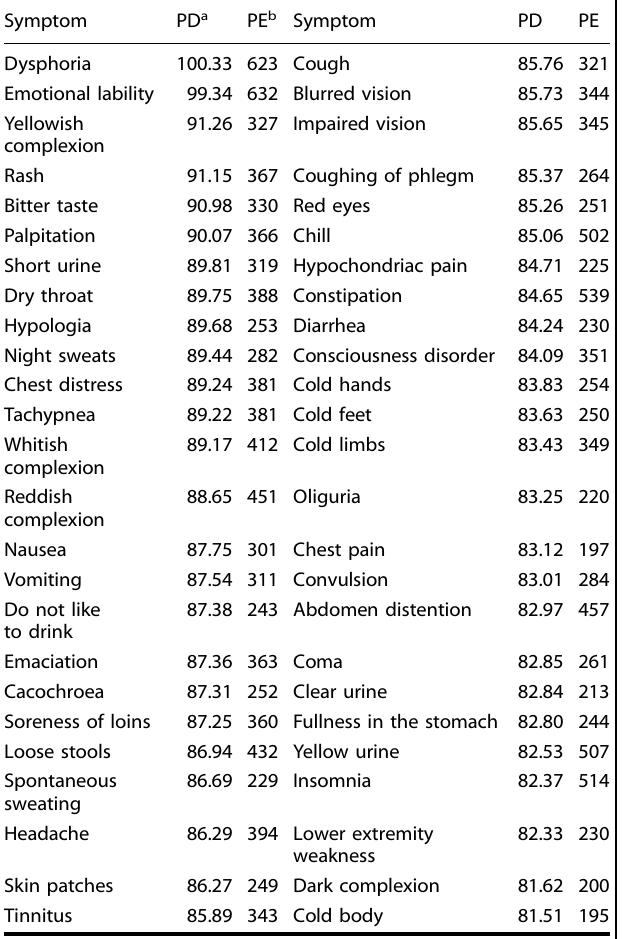
Table 1. Quantifying the diversity of symptom phenotypes in SCN (including the top 50 symptoms sorted by the phenotypic diversity in